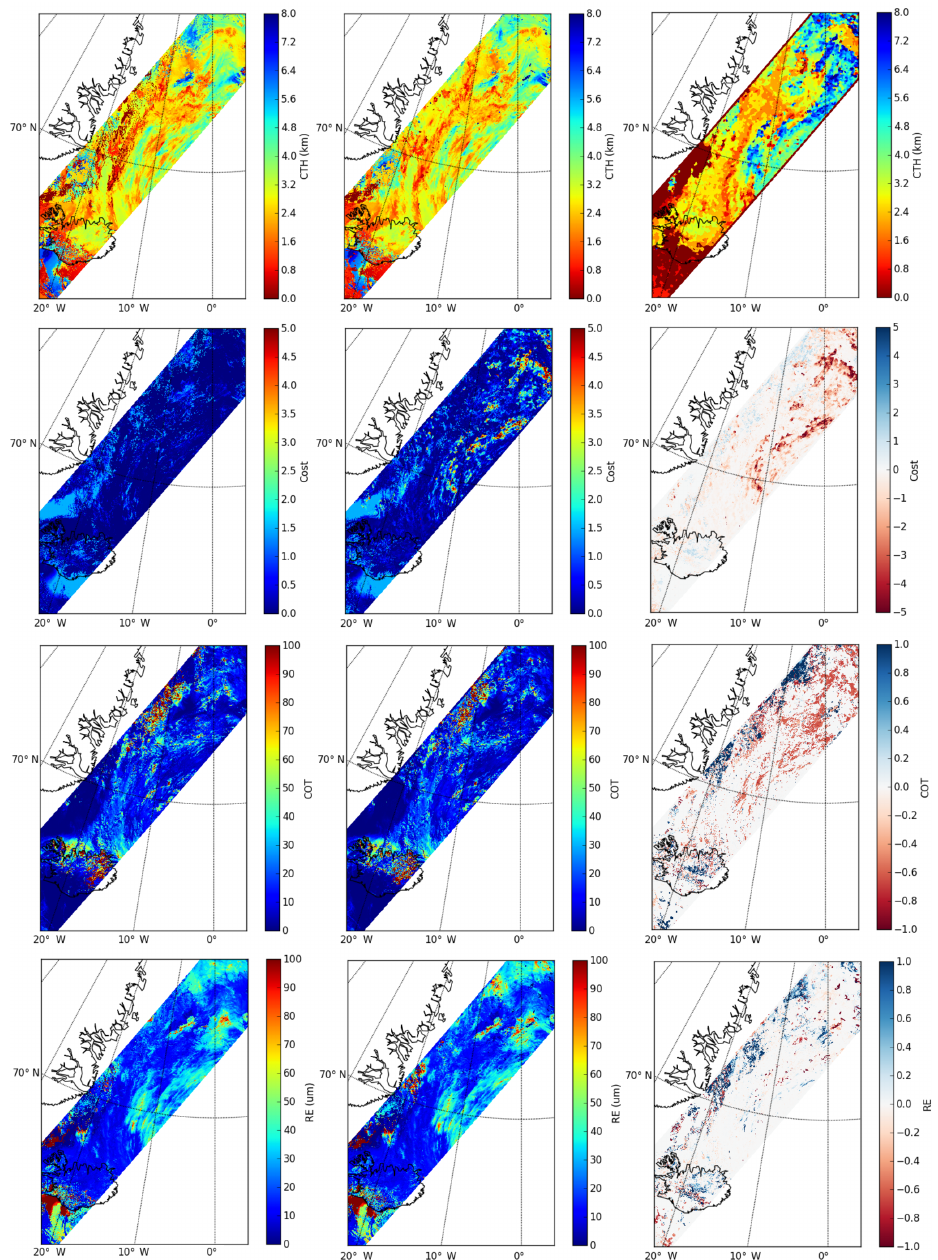
Figure 2. The top row of maps show CTH as retrieved by ORAC, ORAC + stereo and census stereo from left to right. The second row of maps shows the cost associated with each retrieved pixel, with the left plots the costs for ORAC, the central map plots the costs for ORAC + stereo, and the right map plots the difference between the costs. The third row shows the COT maps, with the same arrangement as the second row. The fourth row shows the RE maps with the same arrangement as the above two